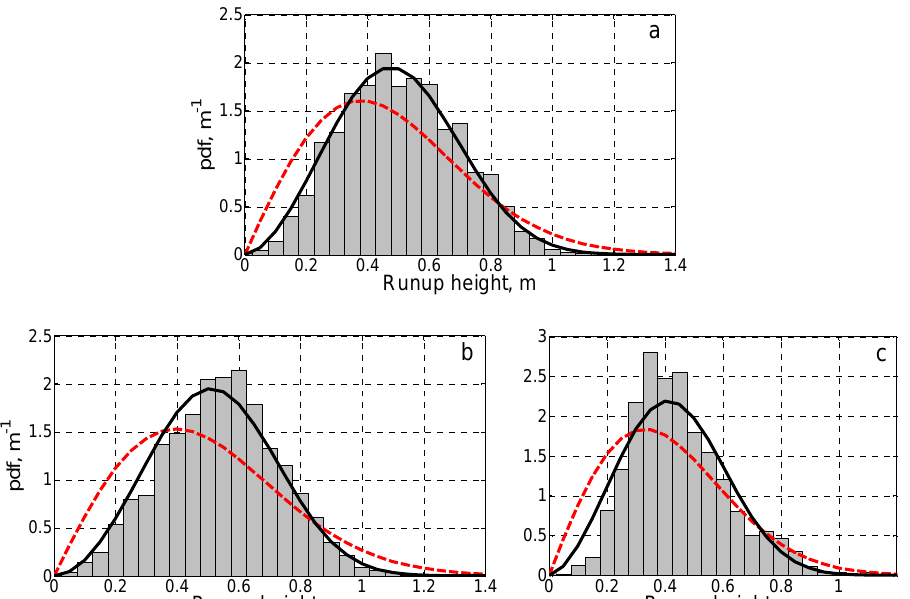
Fig. 6. Averaged distribution of run-up heights within the wave wake; red dashed line corresponds to the Rayleigh distribution (  =0.38 m), black solid line corresponds to the Weibull distribution (  =0.56 m, q =2.77) fitted using the maximum likelihood estimate.